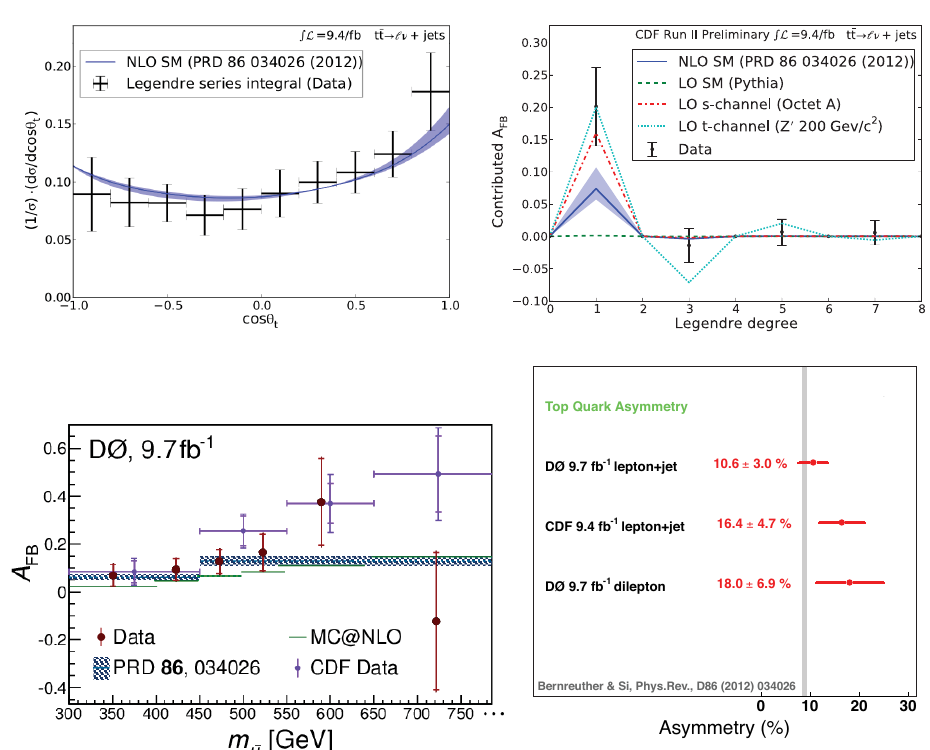
Figure 4. Studies of the top pair forward-backward asymmetry at the Tevatron. Top: Top pair angular distribution (left) and its analysis in Legendre moments (right). Bottom: Di ff erential (left) and inclusive (right) asymmetry